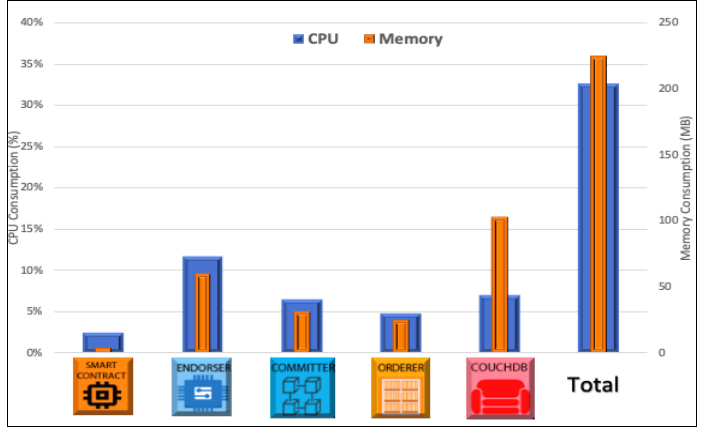
Figure 7. Server